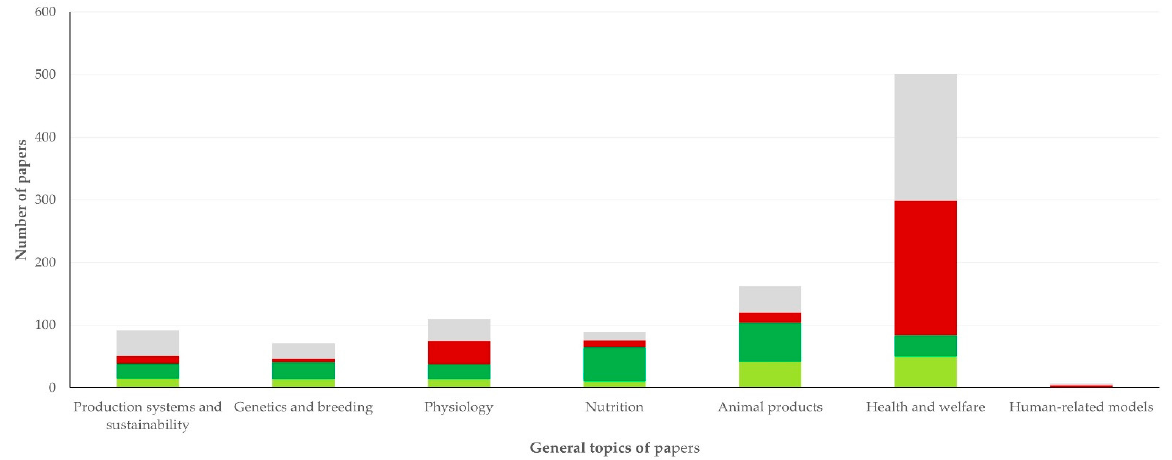
Figure 3. Stack-bar chart of the relative frequency of the general topics in papers on sheep and goats published during 1997–2022 from Greece, with origin from Aristotle University of Thessaloniki, University of Thessaly, Agricultural University of Athens and Hellenic Agricultural Organization— Dimitra (grey: Aristotle University of Thessaloniki, burgundy: University of Thessaly, green: Agricultural University of Athens, green-yellow: Hellenic Agricultural Organization—Dimitra). In seven of the general topics, most papers were published in Small Ruminant Re- search ; differences were seen for the second and third most popular journal across the top- ics, although Livestock Production Science / Livestock Science , and to a lesser degree Sustain- ability , frequently published papers in a variety of topics (Table 3). Table 3. List of journals in which most papers on sheep and goats were published during 1997 to 2022 from Greece, according to general topic of the paper (standard abbreviations were used for journal titles).